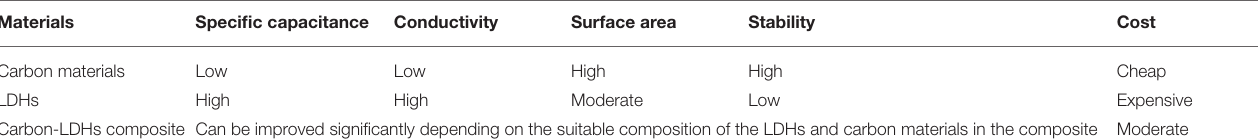
TABLE 3 | Comparison of carbon materials, LDHs and carbon-LDHs composites as electrode materials for supercapacitors.